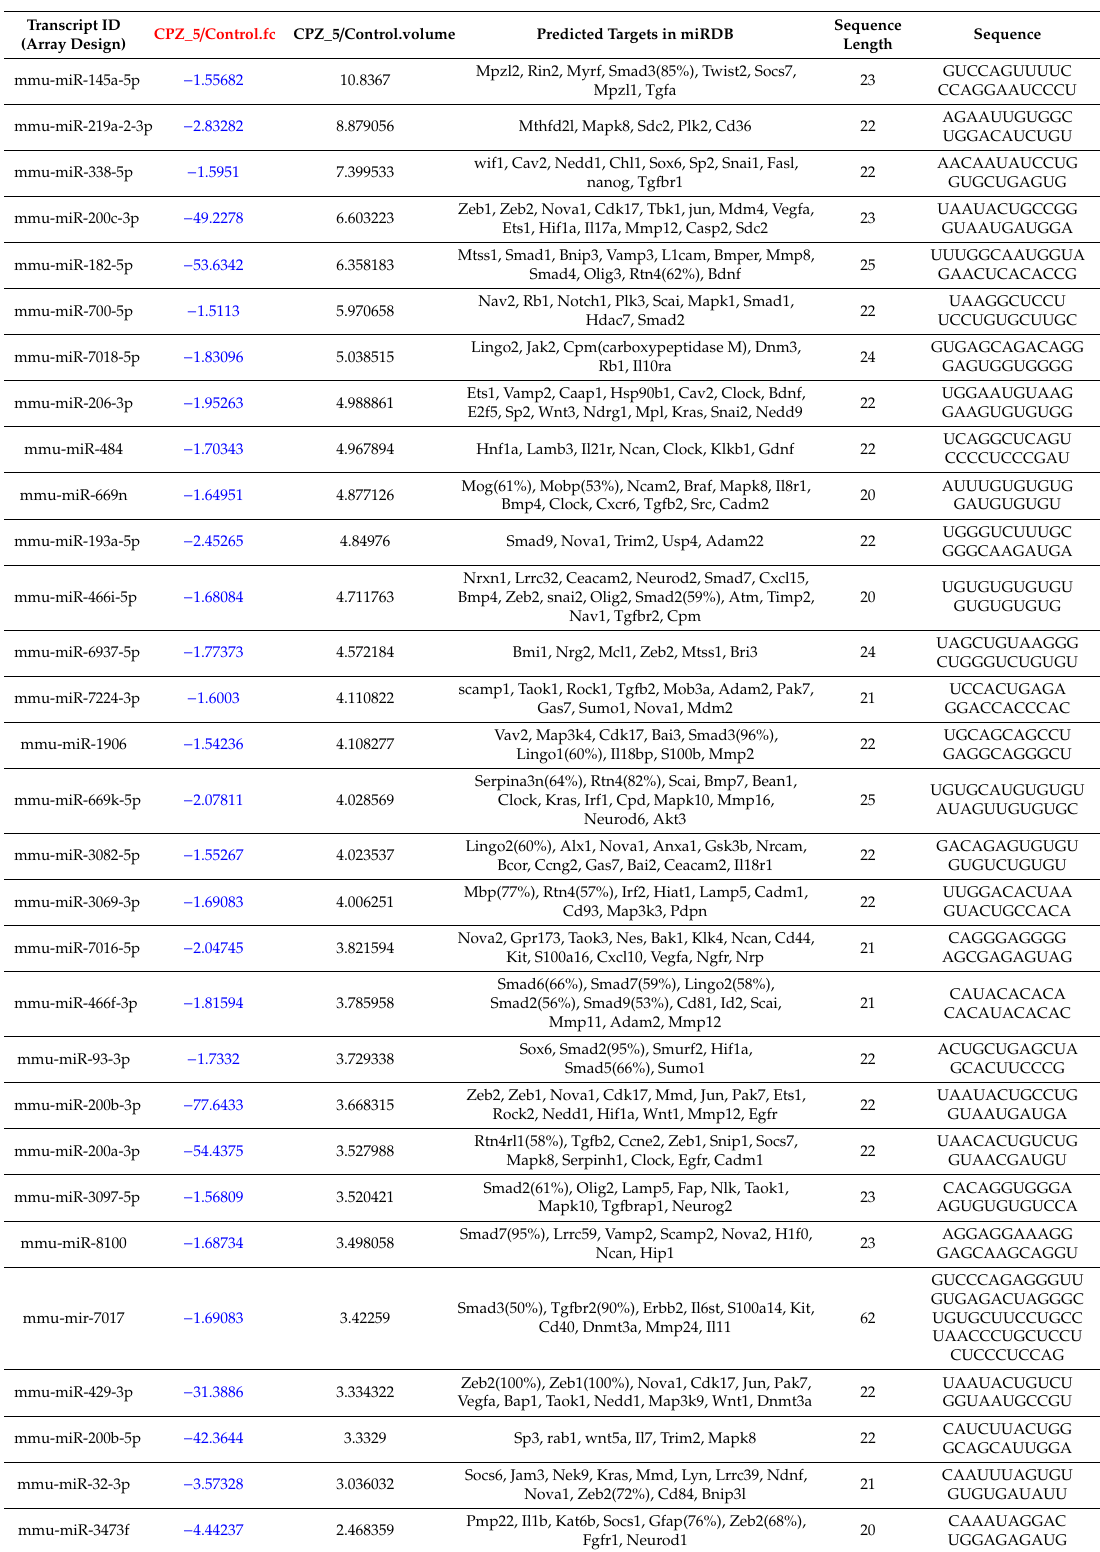
Table 2. DownregulatedmiRNAinacuprizone-induceddemyelinationmousemodel(FoldChange ≥ 1.5). Transcript ID / Control.fc CPZ_5 / (Array Design) CPZ_5